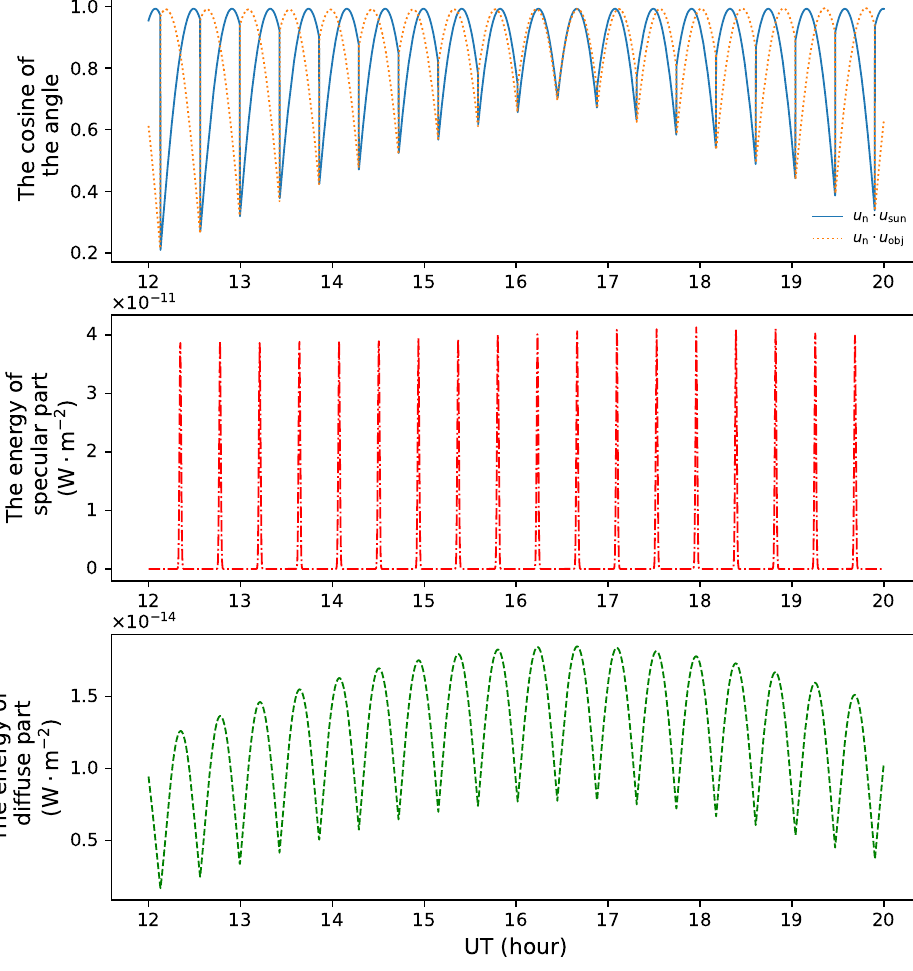
Figure 6. The analysis of synthetic light curve of Attitude